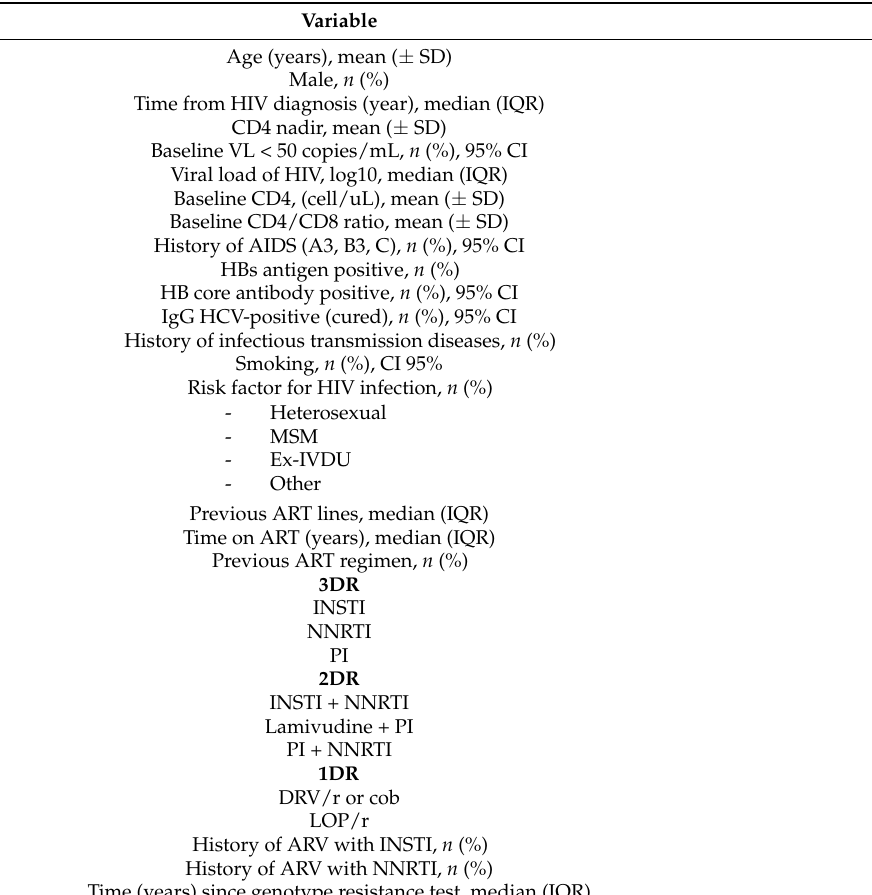
Table 1. General description of 2DR